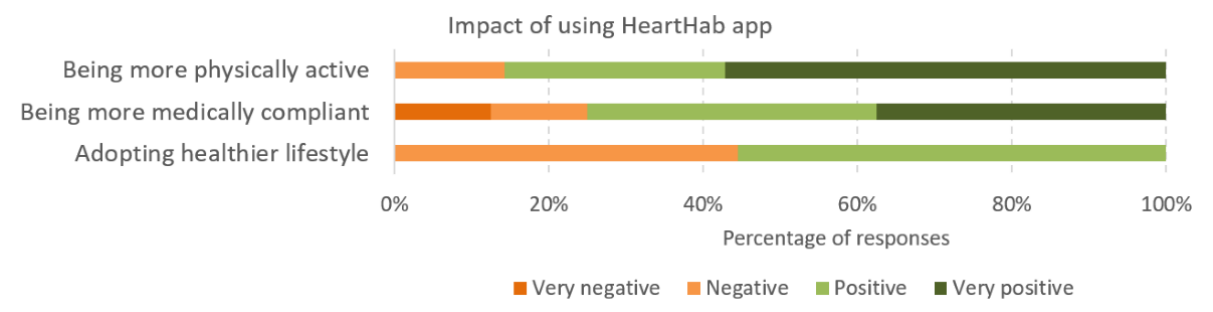
Figure 6. Results of sentiment analysis using NVivo on increasing physical activity levels, promoting medication adherence and adopting healthier lifestyles after using the HeartHab